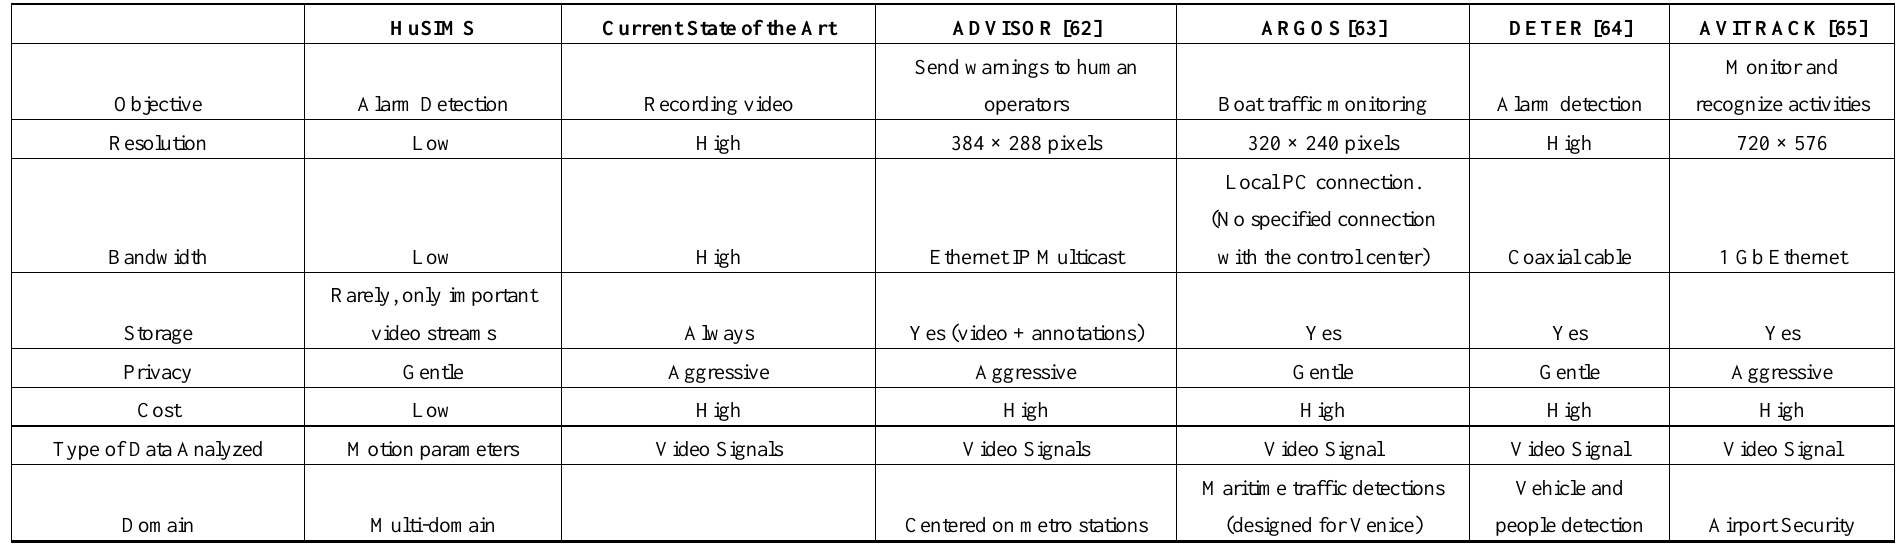
Table 2. HuSIMS feature